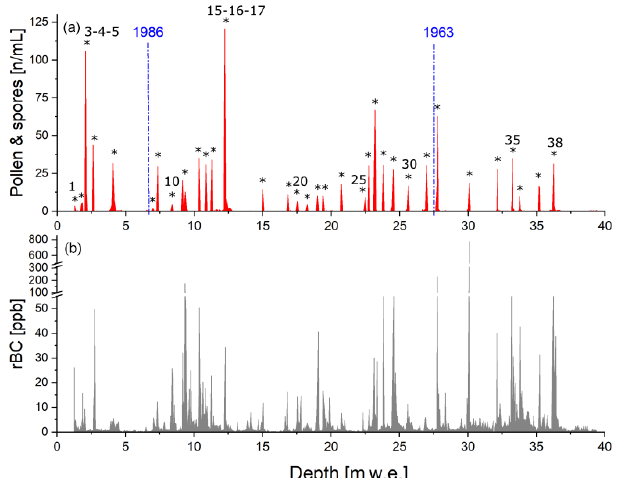
Figure 2. (a) Pollen and spores’ (palynomorphs) concentration; (b) refractory black carbon (rBC) concentration in the ADA16 core. Blue lines indicate the 137 Cs horizons (Di Stefano et al., 2019), to which the absolute annual layer counting chronology is tied. Aster- isks mark every peak of pollen and rBC considered to represent one or more years. Peaks are labelled starting from the top of the core with numbers from 1 to